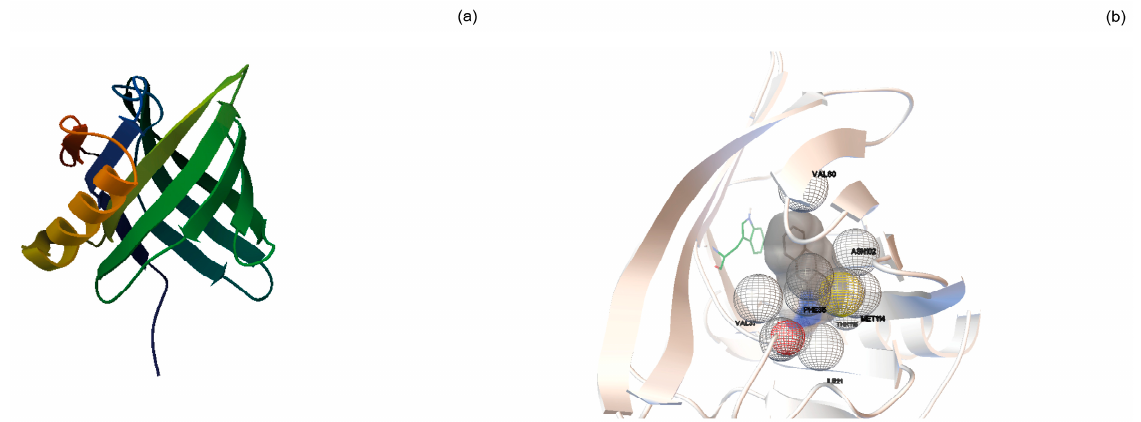
Figure 2. pOBP-1-AMA docking simulation experiments: ( a ) pOBP is a monomer of 157 amino acids containing one disulfide bridge between cysteines at positions 63 and 155 and a single tryptophan residue (Trp) at position 16, accessible to extrinsic fluorophores such as 1-aminoanthracene (1-AMA); ( b ) The image depicts the position of 1-AMA (in gray color) in the β -barrel structure of pOBP. The single tryptophan residue is highlighted in green color.